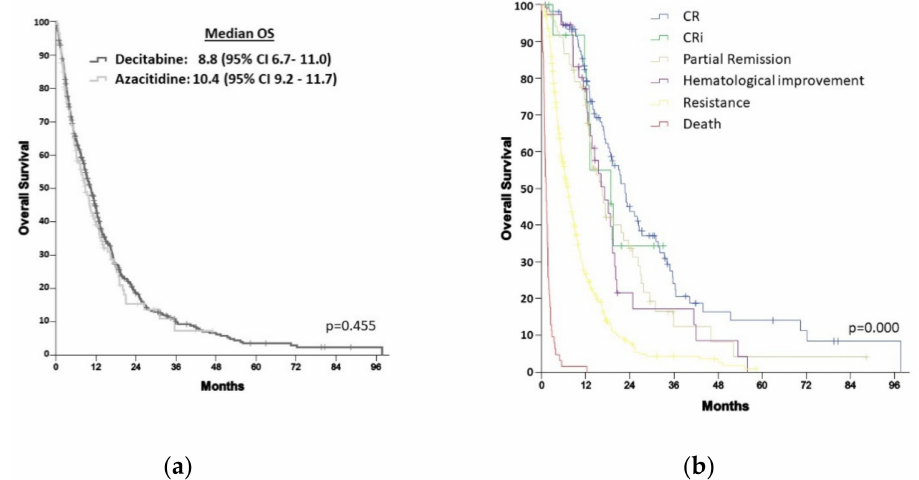
Figure 4. ( a ) Overall survival among patients treated with azacitidine vs. decitabine; ( b ) Overall survival according to response. CR, complete remission; CRi, complete remission with incomplete blood count recovery; OS, overall survival; PR, partial